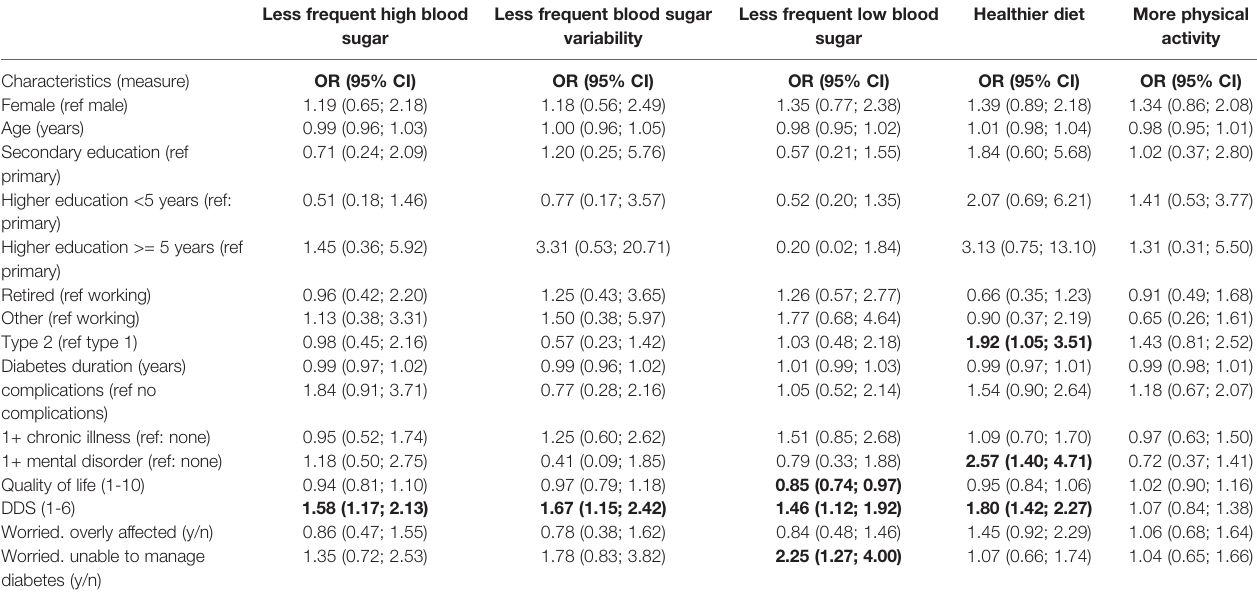
TABLE 3A | Predictors of reporting improved diabetes self-management behaviors during the pandemic.